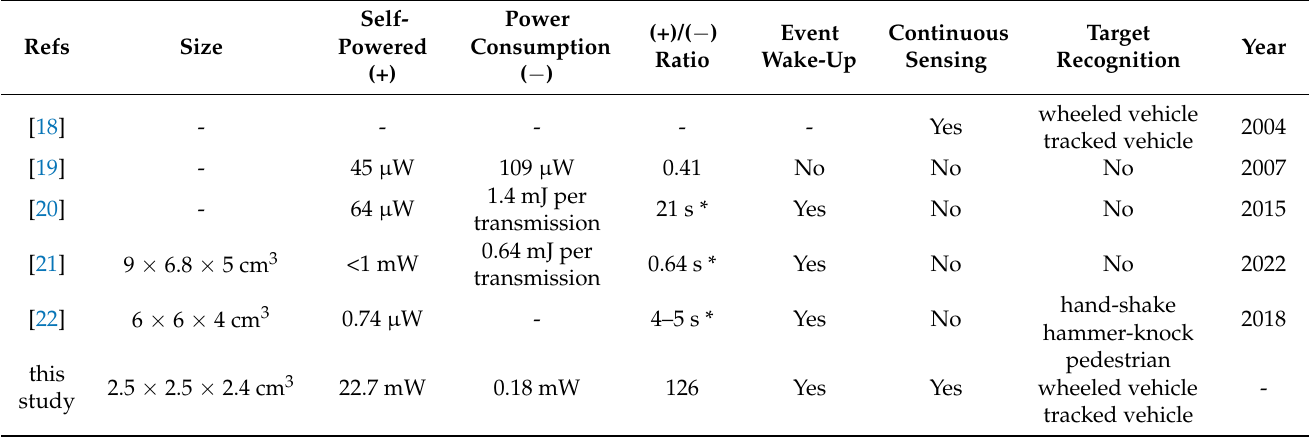
Table 1. Vibration sensing